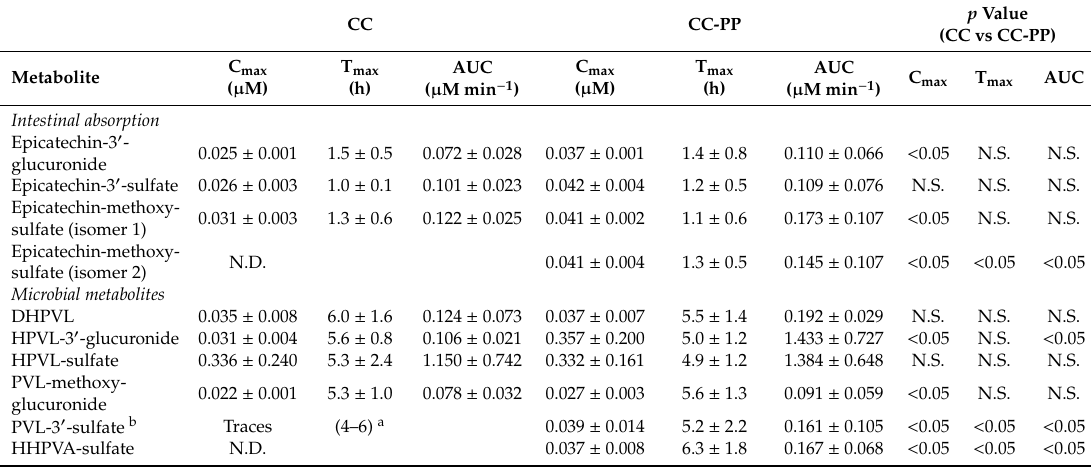
Table 3. Nutrikinetic parameters of metabolites detected in human plasma after consuming a conventional soluble cocoa product (CC) and a flavanol-rich soluble cocoa product (CC-PP) containing 19.80 and 68.25 mg of flavanols, respectively. Values represent mean ± standard deviation ( n = 13). CC CC-PP